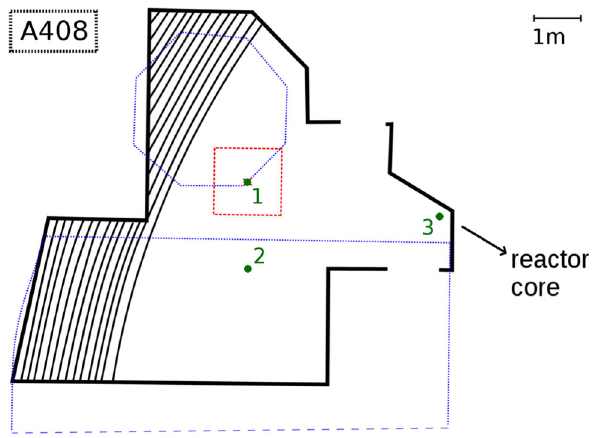
Fig. 6 Room A408 at the nuclear power plant Brokdorf, where the CONUS experiment is located. Blue outlines mark the water ponds as overburden. (1) center of CONUS shield and location of BSS during DS-3, (2) location of monitor neutron counter during DS-3, (3) location